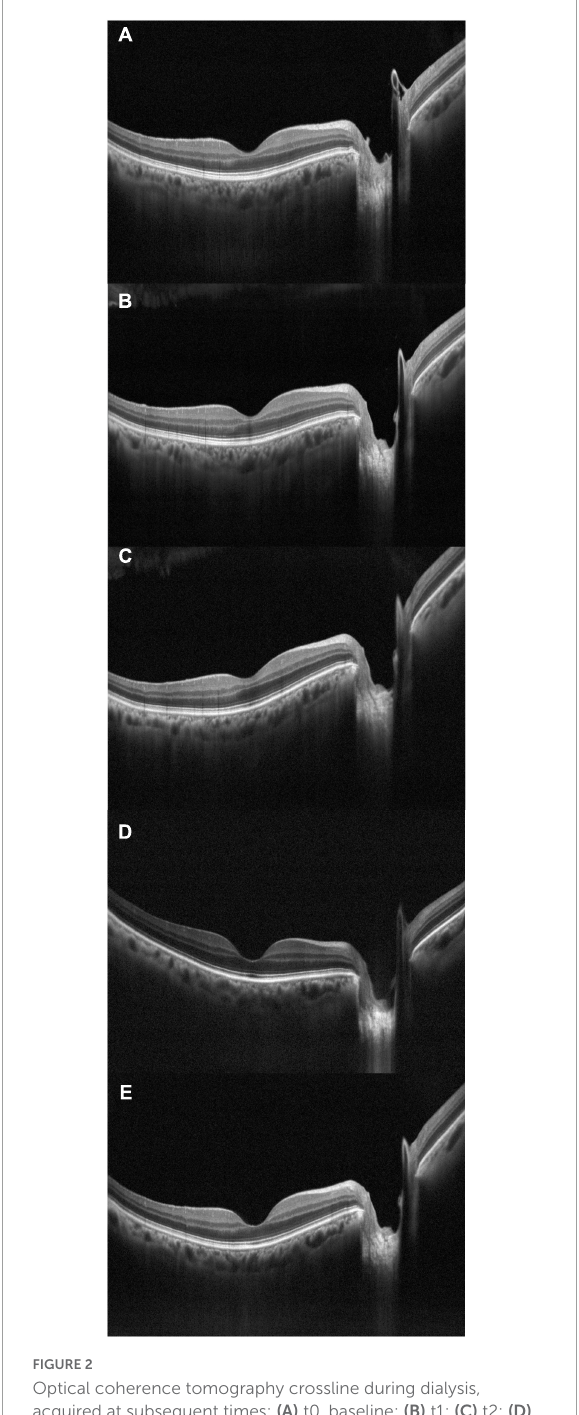
FIGURE2 Optical coherence tomography crossline during dialysis, acquired at subsequent times: (A) t0, baseline; (B) t1; (C) t2; (D) t3; (E) t4.